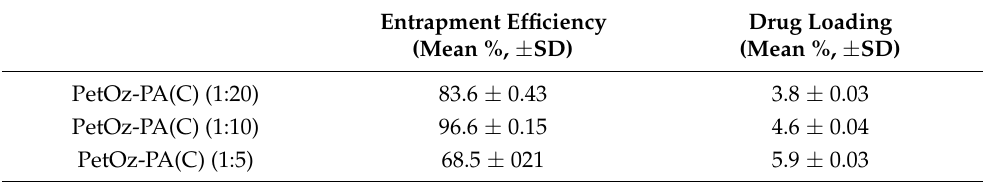
Table 2. Drug loading and drug entrapment efficiencies of PetOz-PA(C) ( n =